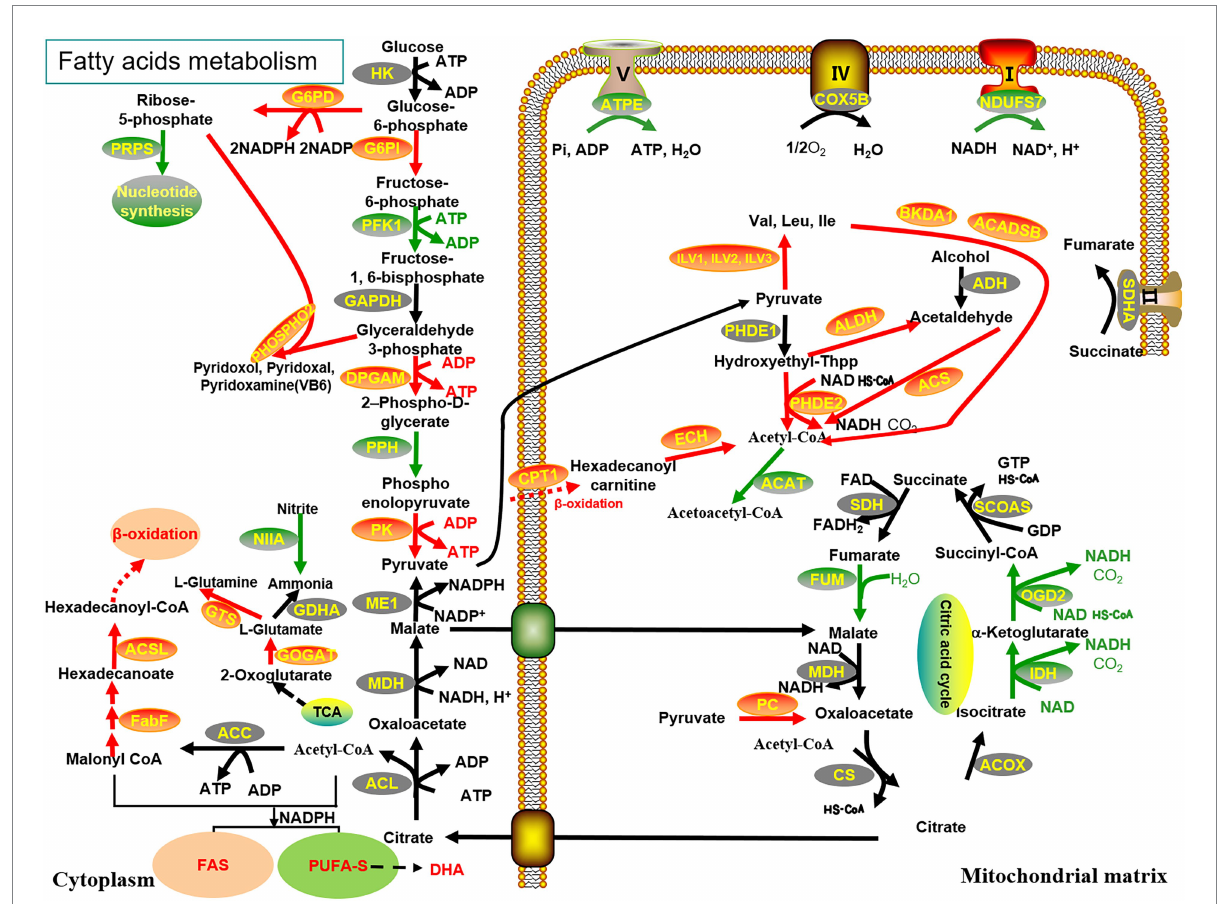
FIGURE 4 Reconstruction and illustration of the key genes with highly enhanced transcriptional levels and their metabolic processes. The metabolic processes of the TCA cycle, glycolysis pathway, PPP, fatty acid metabolism, β -oxidation, amino acid biosynthesis and degradation, oxidative phosphorylation, nitrogen metabolism, and vitamin B6 synthesis are associated with the fermentation of Schizochytrium sp. FJU-512 when malate is added. Red (upregulated), black (no distinct disparities), and green (downregulated); arrows indicate transcriptional regulation of genes: solid line arrows represent a one-step reaction, while dashed ones represent a multi-step reaction. The abbreviations of all genes are detailed in Supplementary Table 2